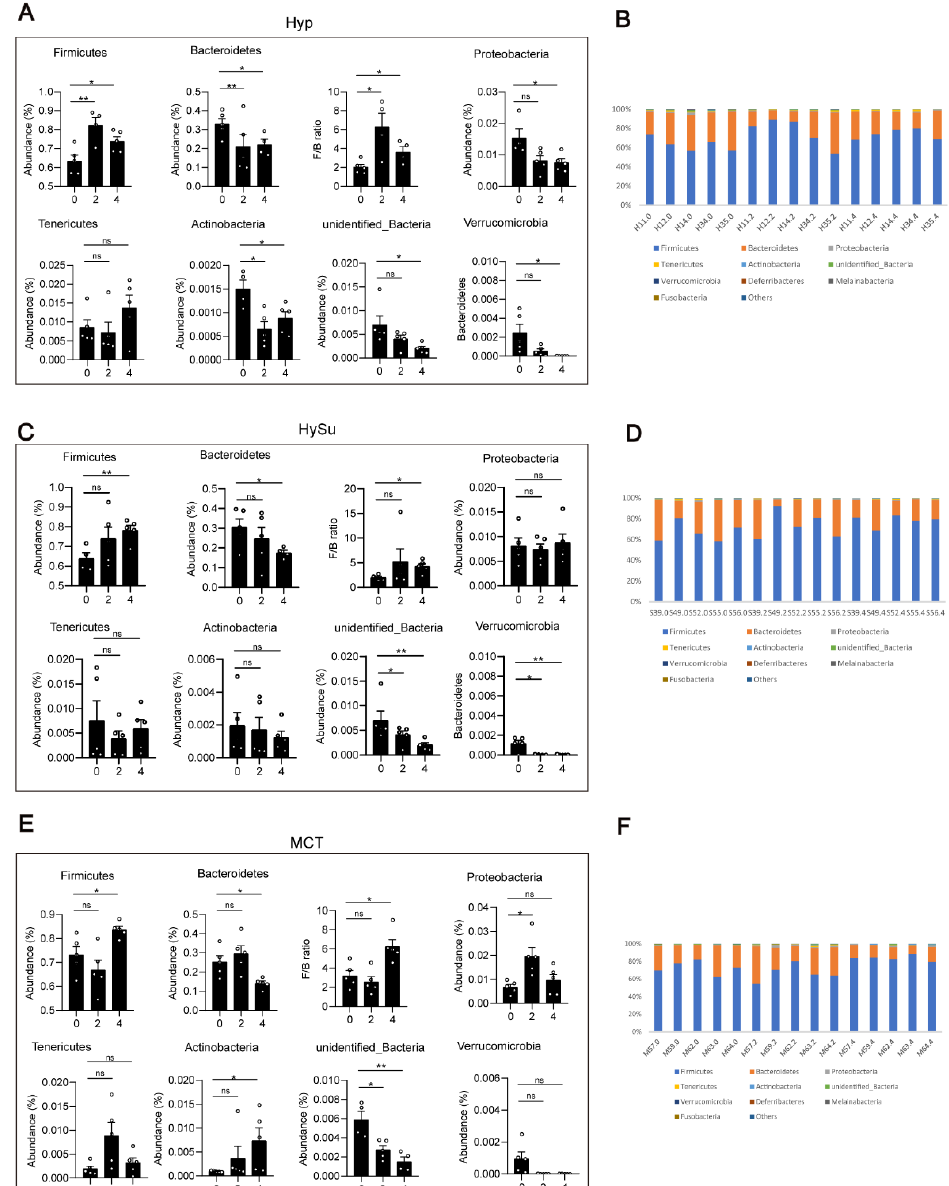
Figure 3. Fecal microbial composition at the phylum level. ( A – F ) The changes in Firmicutes , Bacteroidetes , Proteobacteria , unidentified bacteria , Melainabateria , and the ratio of Firmicutes/Bacteroidetes in Hyp- ( A , B ), HySu- ( C , D ), and MCT- ( E , F ) induced PH rats. Data are presented as the mean ± SEM, n =